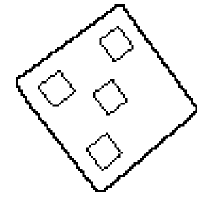
Figure 8 Edge of pattern.